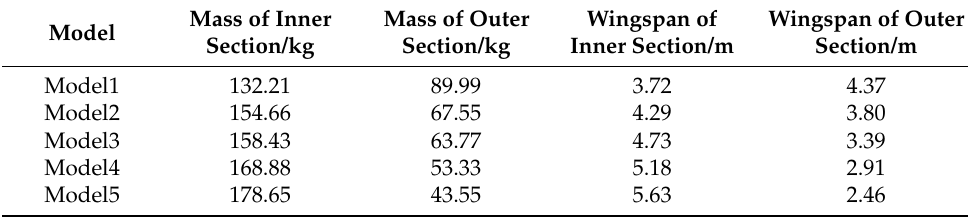
Figure 5. Schematic diagram of the dimensions of the inner and outer sections corresponding to the pre-selected models. The sweep angle of the inner section Λ in = 0 ◦ and outer section Λ out = 30 ◦ . Table 4. Mass and dimensions of the inner and outer sections of the pre-selected models.